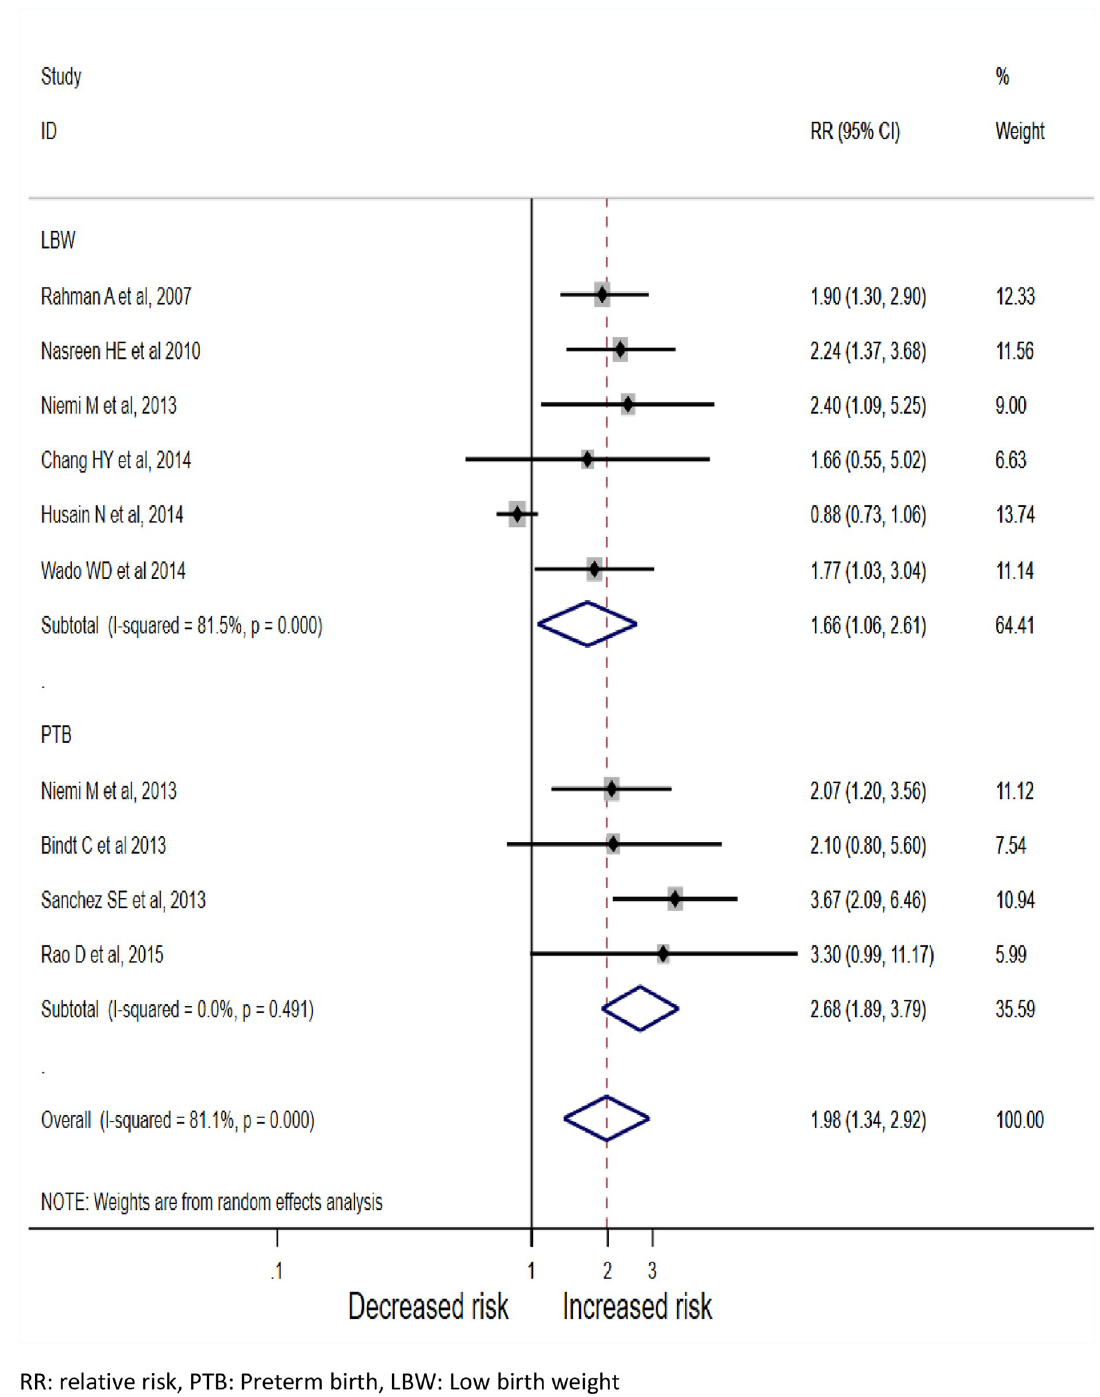
Fig 2. Association between antenatal depression and adverse birth outcomes (N = 9, 2007–2017).